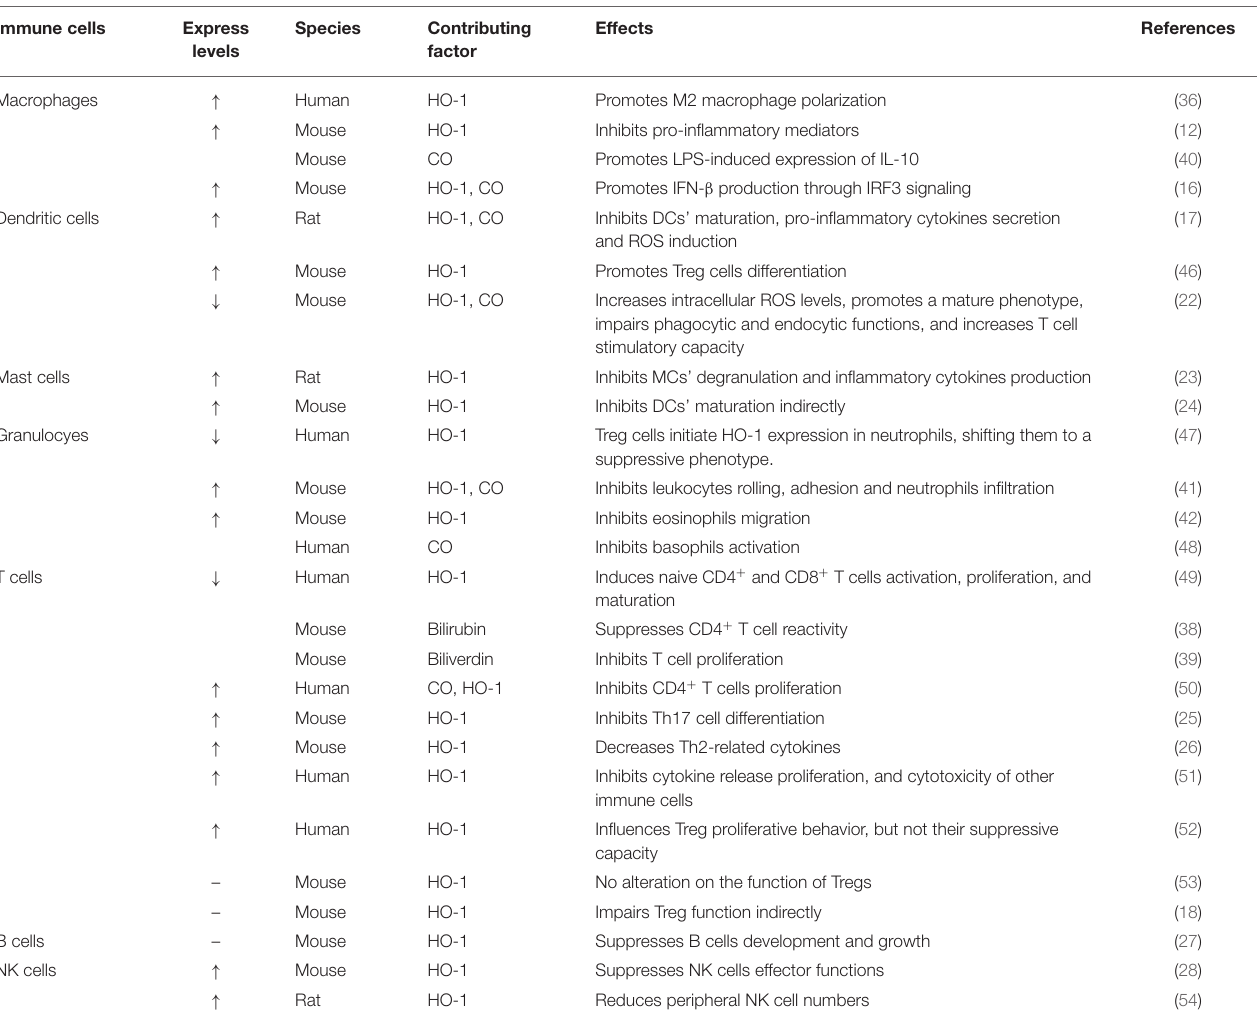
TABLE 1 | Effects of heme oxygenase-1 on innate and adaptive immune responses based on experiments. Immune